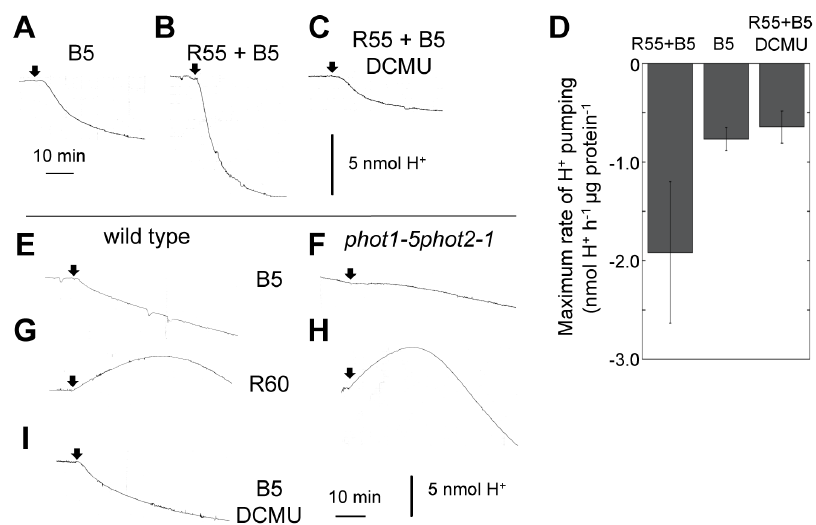
Figure 2. BL-dependent H + -pumping enhanced by RL-activated guard cell photosynthesis. A–C. H + -pumping induced by the irradiation with BL with (B and C, [R55 + B5]) or without RL irradiation (A, [B5]) in wild-type guard cell protoplasts. Guard cell protoplasts (50 m g protein) were irradiated with 5 m mol m 2 2 s 2 1 BL with or without 2 to 3 h pre-irradiation and background irradiation with 55 m mol m 2 2 s 2 1 RL. DCMU (dissolved in DMSO) was administered to the protoplasts before pre-irradiation with RL at a final concentration of 10 m M (0.01% DMSO) (C). D, Maximum rates of H + -pumping by guard cell protoplasts under different light conditions as in A to C. Data represent means 6 SD of three independent experiments. E– I. pH changes induced by irradiation with BL or RL in wild-type (E, G, and I) and phot1phot2 (F and H) guard cell protoplasts. Guard cell protoplasts (50 m g protein) were dark-adapted for 1 h before 5 m mol m 2 2 s 2 1 BL (E, F, and I [B5]) or 60 m mol m 2 2 s 2 1 RL (G and H [R60]) was applied where indicated by arrows. DCMU was administered before dark-adaptation at 10 m M (I).